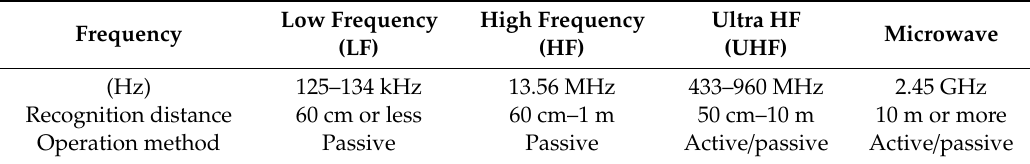
Table 3. Types of radio frequency identification (RFID) for